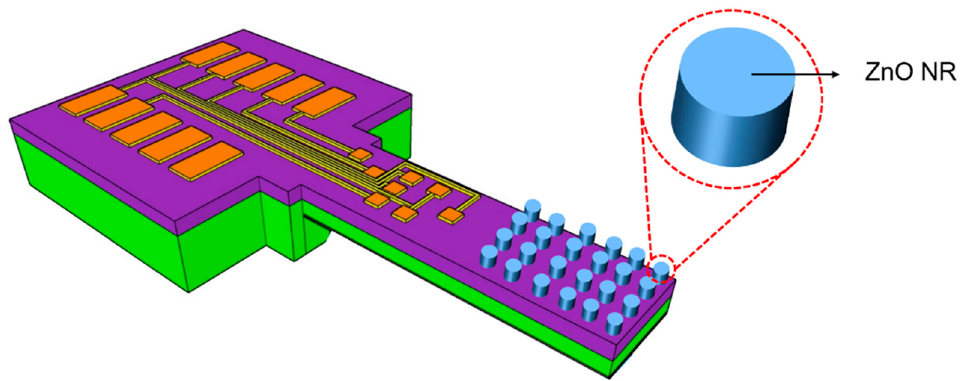
Figure 1. Schematic of micro-electro-mechanical system (MEMS) silicon cantilever sensor functionalized with ZnO nanorods (NRs) on the top surface.